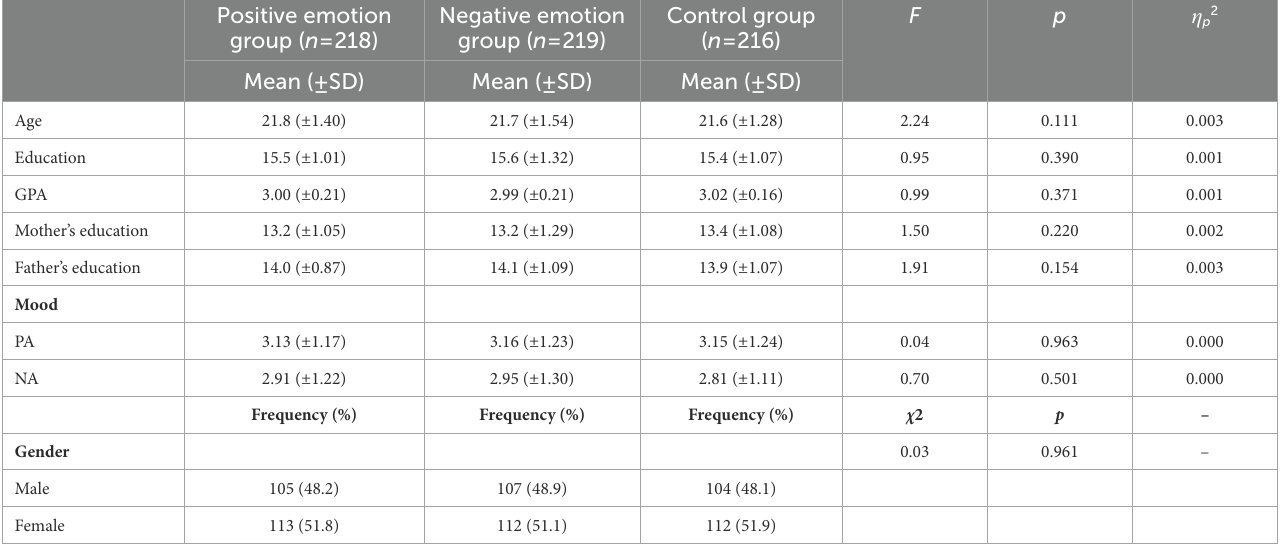
TABLE 3 Demographic and mood characteristics of the sample in Study 2 ( n =